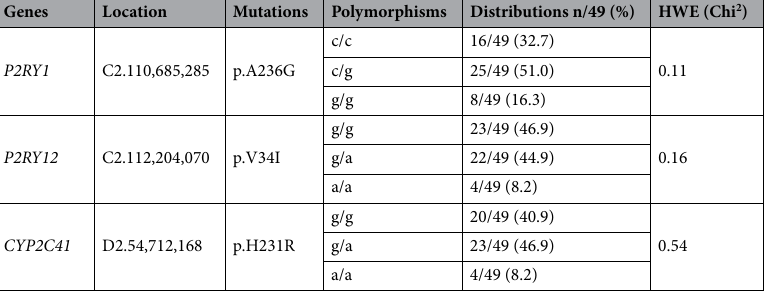
Table 1. Frequencies of genetic polymorphisms in three targeted genes ( P2RY1 , P2RY12 , and CYP2C41 ). HWE; Hardy–Weinberg